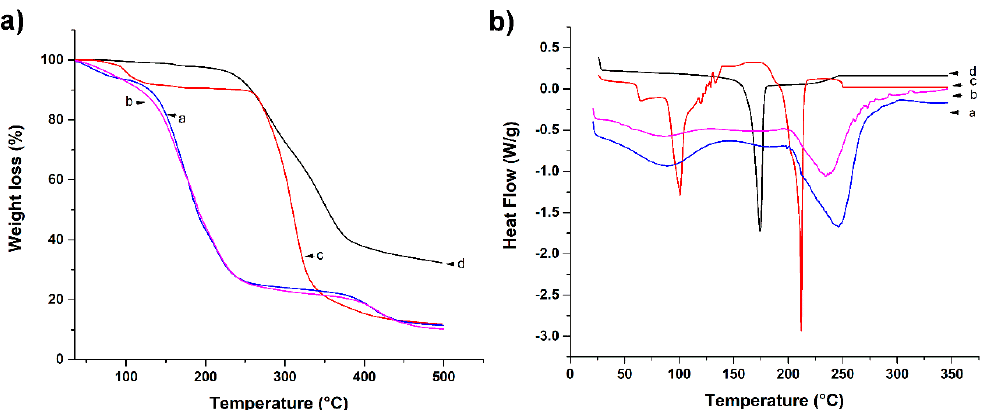
Figure 4. Thermal analysis of nanoparticle-coated alginate membrane using ( a ) thermogravimetric analysis (TGA) and ( b ) differential scanning calorimetry (DSC). The thermal properties of the M4 membrane, CNp-M4 membrane, CNp, and curcumin are represented as a, b, c, and d, respectively.